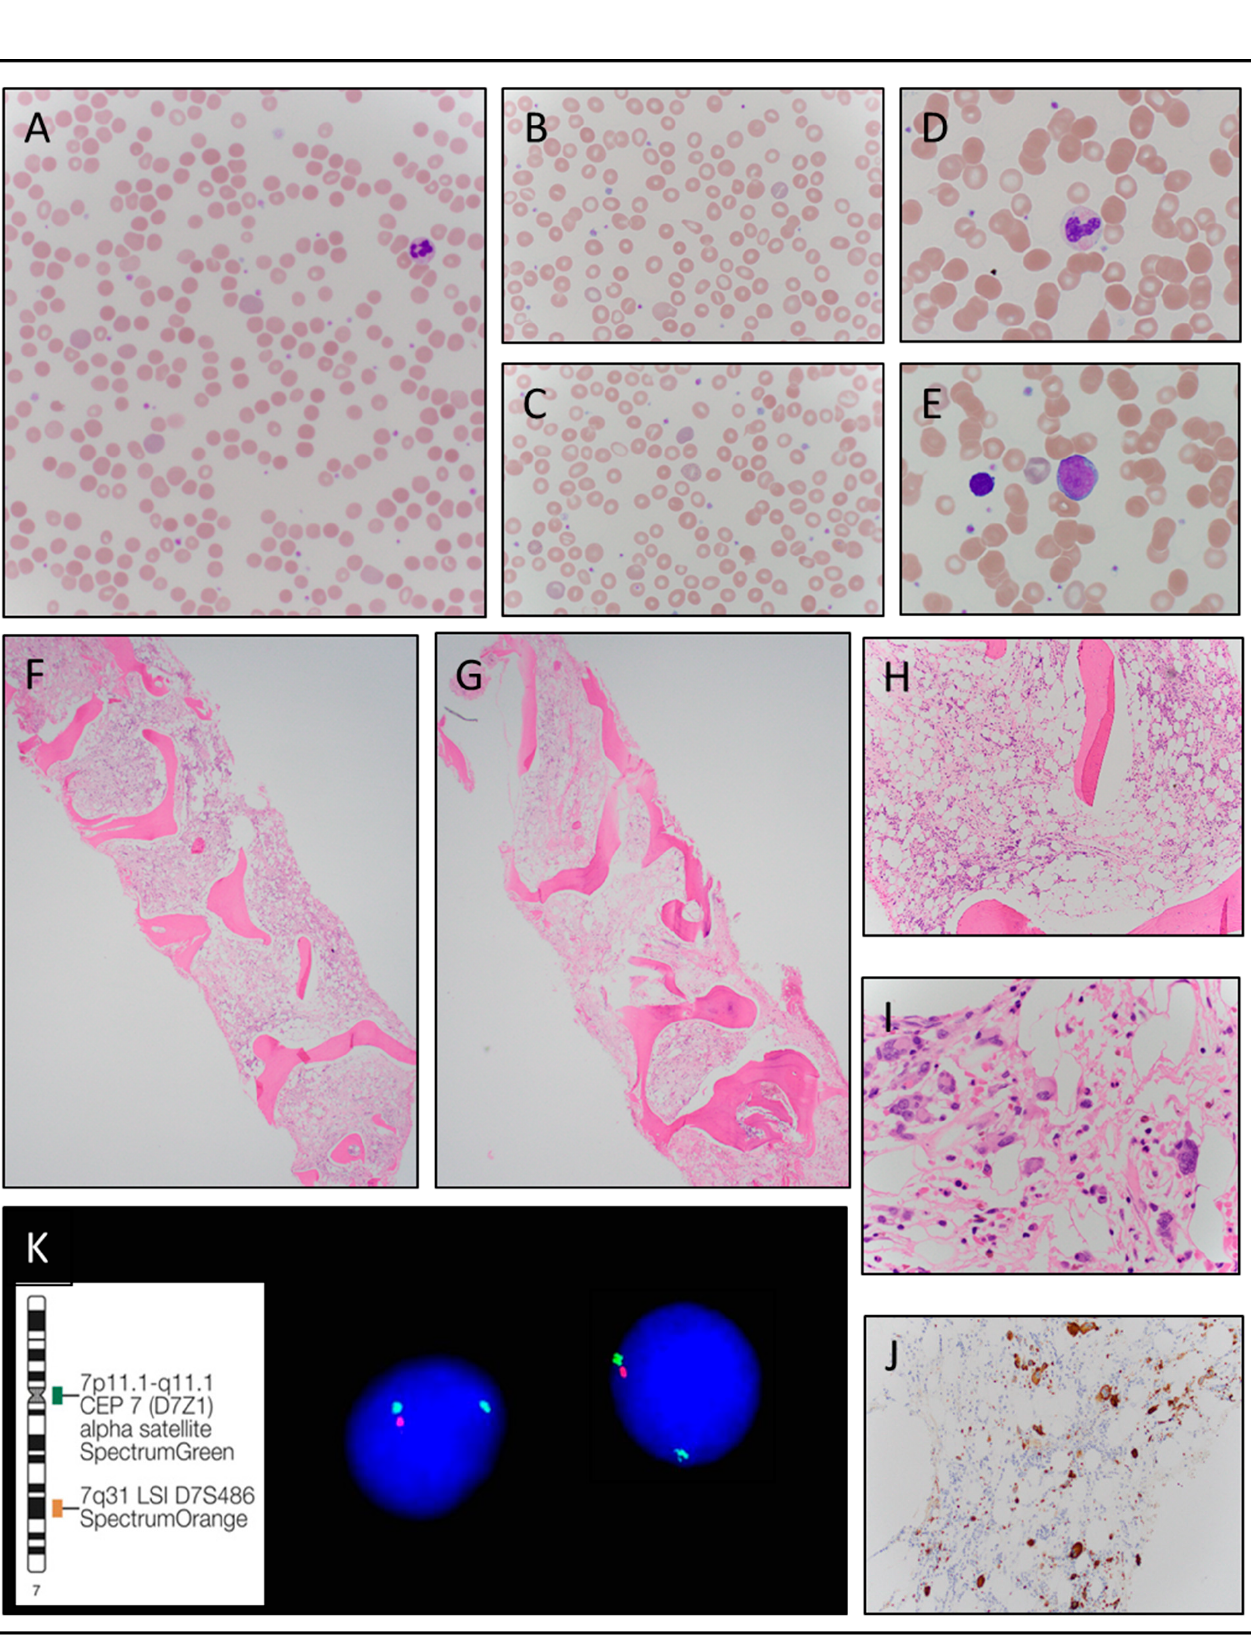
Figure 1. Case 1. ( A ) Peripheral blood smear reveals a dimorphic population. ( B ) Occasional tear drop red blood cells (60× oil). ( C ) Scattered red cells with basophilic stippling (100× oil). ( D ) Occasional neutrophils with Döhle-like bodies (100× oil). ( E ) Occasional circulating blasts (100× oil). ( F , G ) Core biopsies with hypocellular for age erythroid dominant trilineage hematopoiesis (2×). ( H ) Hy- pocellular for age erythroid dominant trilineage hematopoiesis (10×). ( I ) Loose clusters of megakar- yocytes including different forms (60× oil). ( J ) CD42b highlights megakaryocytes including small hypolobated forms (40×). ( K ) Fluorescence in situ hybridization (FISH) analysis of interphase pe- ripheral blood cells with abnormal probe signal pattern consistent with deletion of the 7q31 region using the Abbott Molecular D7S522 IL, USA and CEP7 dual color probe set with Spectrum Orange